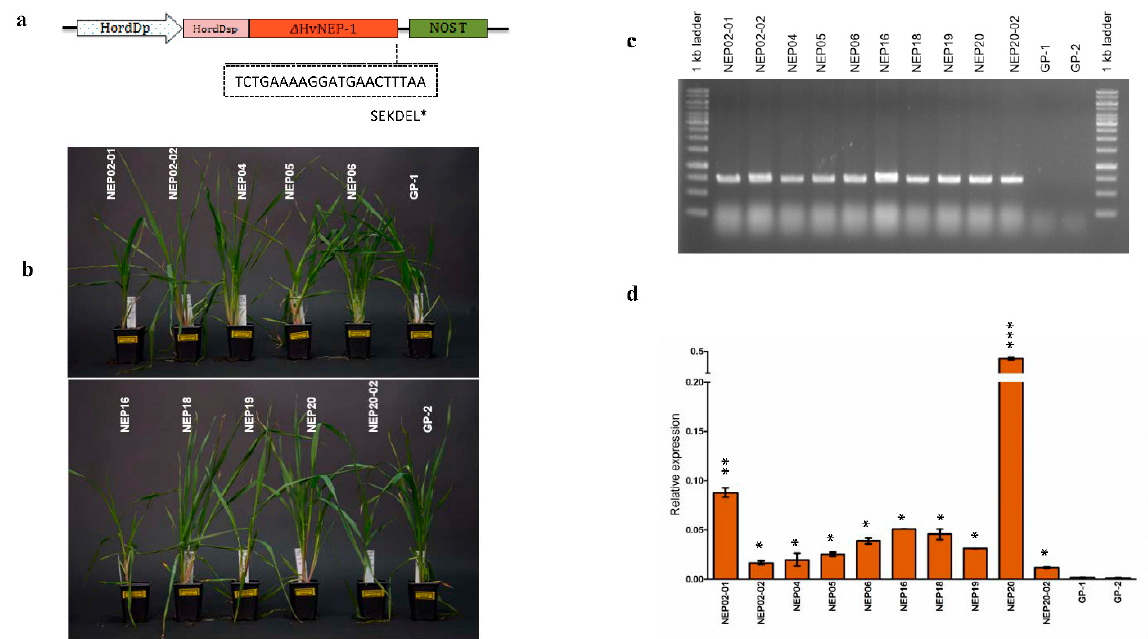
Figure 1. Analysis of transgenic barley lines overexpressing HvNEP-1 . ( a ) Gene expression construct used for Agrobacterium-mediated transformation, HordDp: D-hordeum promoter, HordDsp: D-hordeum signal peptide, ∆ HvNEP-1: signal peptide lacking HvNEP-1, and NOS terminator; ( b ) transgenic HvNEP-1 -overexpressing barley lines used for downstream studies; ( c ) PCR analysis of transgenic HvNEP-1 -overexpressing barley lines using P5 amplifying fragments inside the HordD promoter and HvNEP-1 gene; and ( d ) qPCR analysis of transgenic lines with variable expression of the transgene. Values in d are the mean of 3 independent technical replicates and were analyzed by Student’s t -test. Error bars = mean + sd. Significant differences between transgenic and non-transgenic plants are labelled with asterisks: * p < 0.05, ** p < 0.01, and *** p < 0.001.